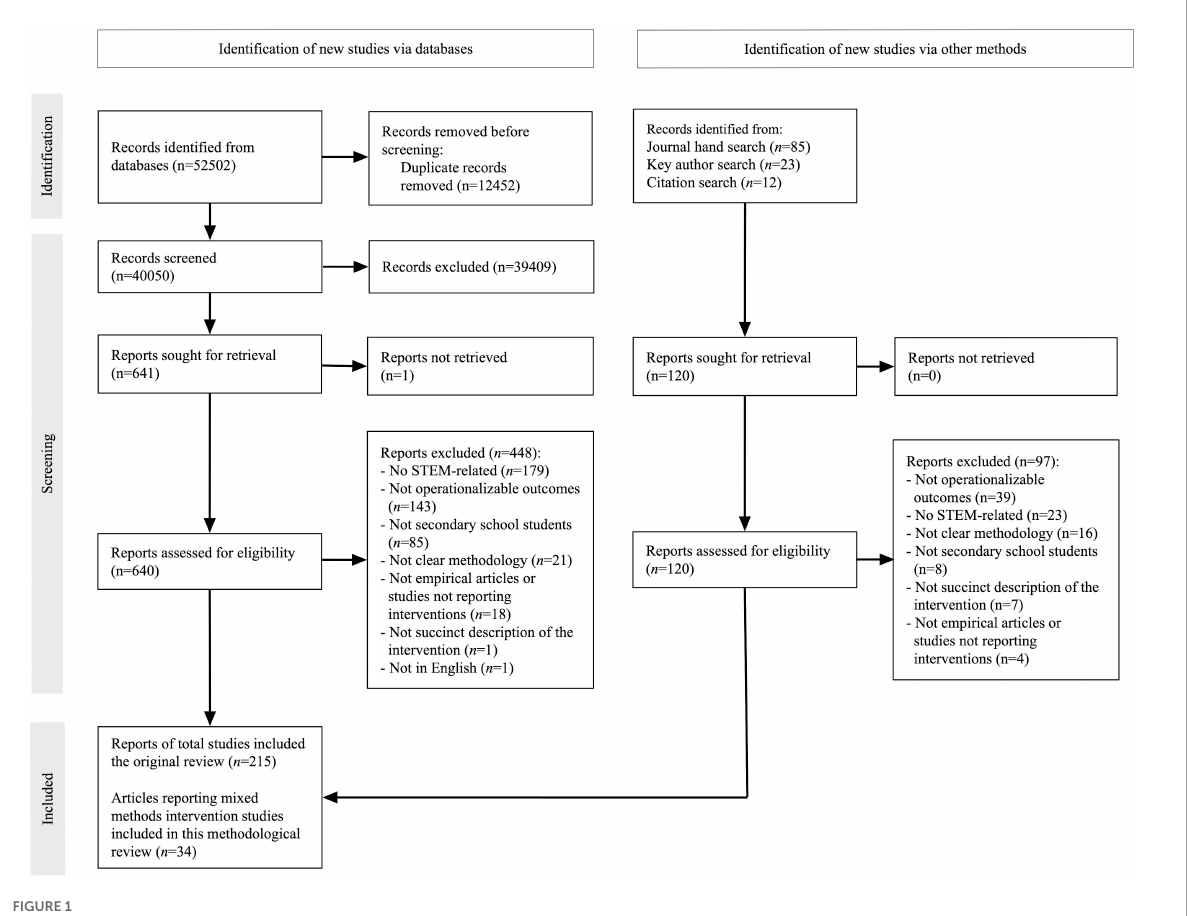
FIGURE1 Preferred reporting items for systematic reviews and meta-analyses (PRISMA)